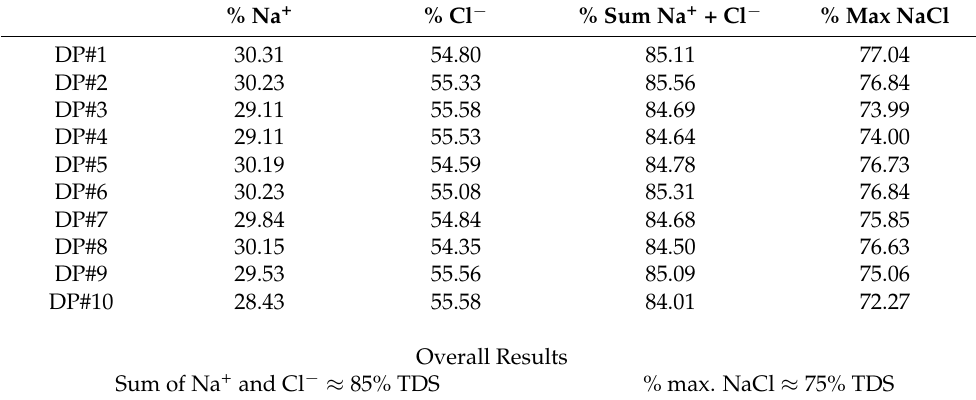
Table 6. Difference between % NaCl and % sum of Na + + Cl − per